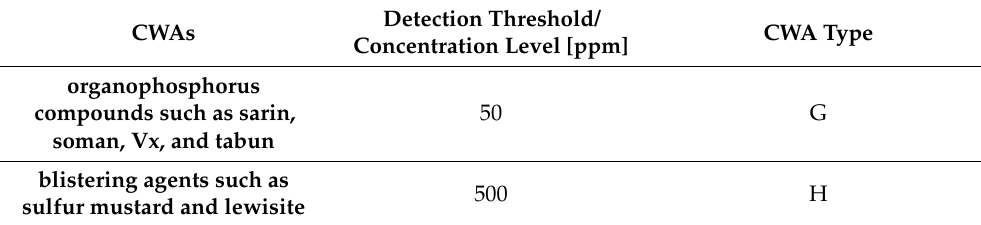
Table 1. Detection threshold of particular CWAs by the IMS module. CWAs